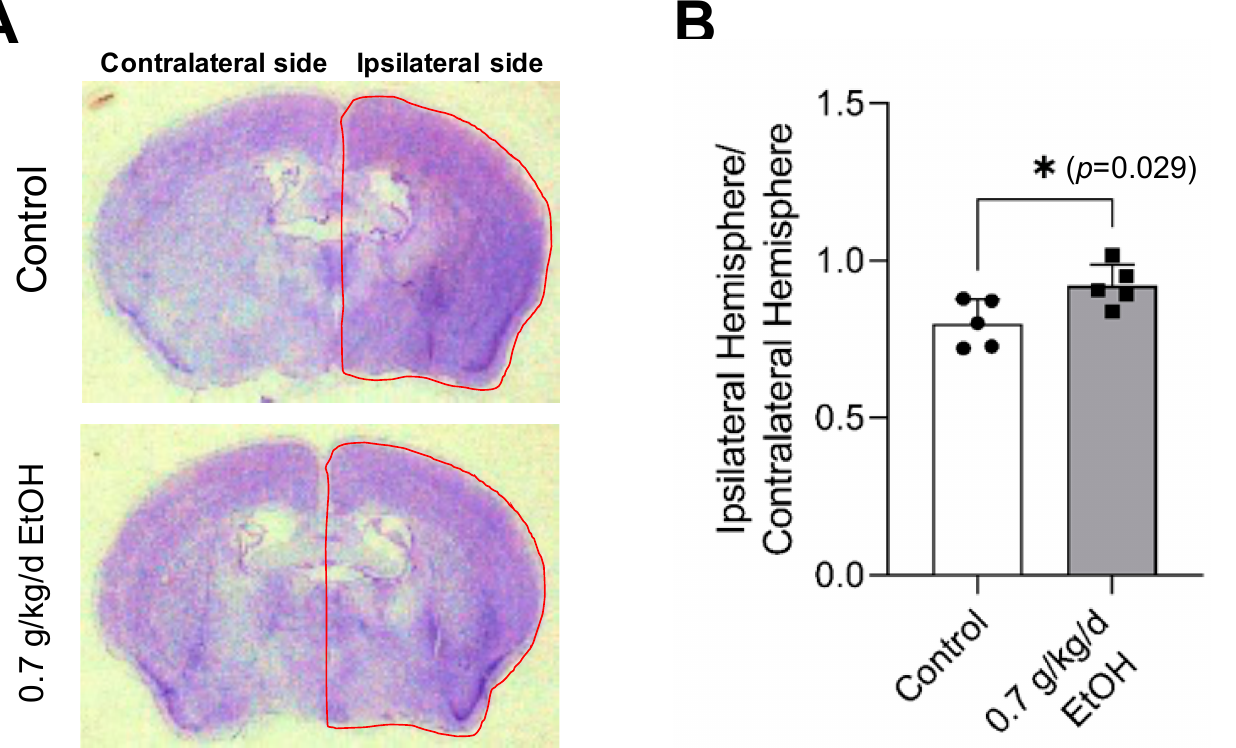
Figure 3. Effect of LAC on cerebral I/R damage at two weeks of reperfusion. ( A ) Representative brain sections stained with Cresyl violet. ( B ) The ratio of ipsilateral hemisphere/contralateral hemisphere. Values are means ± SD for five mice in each group; * p < 0.05 vs. Control. Analyzed using an unpaired t -test.